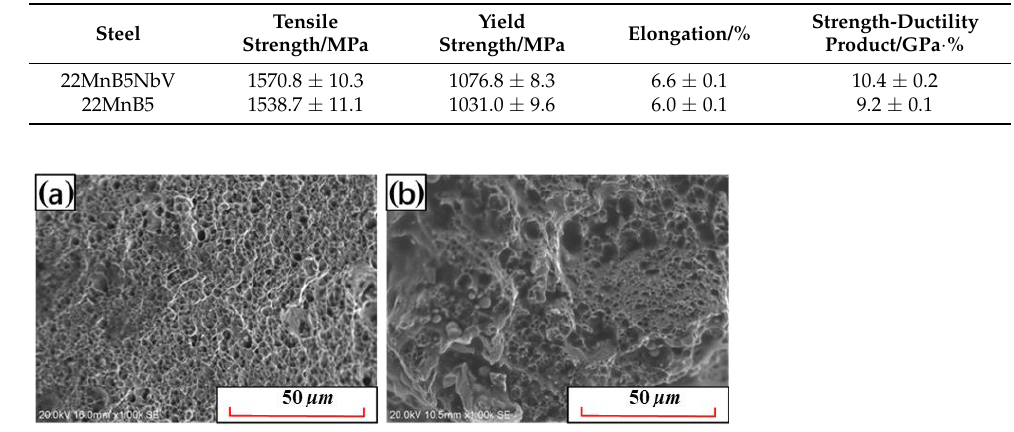
Figure 17. Comparison of microstructures and grains between 22MnB5NbV and 22MnB5 steel: ( a ) microstructure of 22MnB5NbV; ( b ) microstructure of 22MnB5; ( c ) grain of 22MnB5NbV; ( d ) grain of 22MnB5. In order to explore the essential reasons for the difference in the grain sizes of 22MnB5NbV and 22MnB5 steel, the precipitates at the grain boundaries and within the grains have been detected and analyzed by scanning electron microscopy, the result is shown in Figure 18. The detection results showed that a certain number of precipitates appeared in the grain boundaries and in the grains, of which the size of the precipitates is basically in the range of 100 – 200 nm. Meanwhile, the type of precipitation is mainly com- posed of (Nb, Ti, V) carbides. Current research generally agrees that micron-sized precip- itates in steel can lead to compromised benefits of alloying and even cause degradation of mechanical properties [29 , 33,34]. However, diffusely distributed nanoscale nitrides or car- bonitrides can effectively pin down grain boundaries, hindering grain growth and signif- icantly improving the strength and toughness of the material [33,35,36]. Therefore, the addition of Nb and V elements can significantly inhibit the growth of grains through the